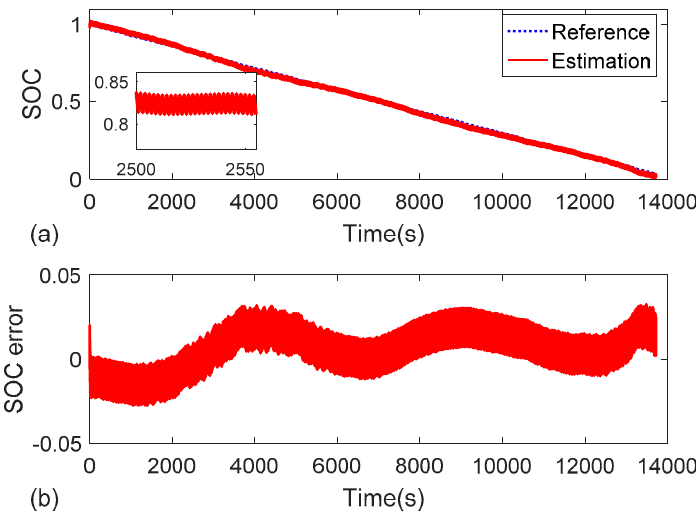
Figure 4. SOC estimation result with sliding mode observer (SMO) under Federal Urban Driving Schedule (FUDS) condition. ( a ) SOC; ( b ) SOC error.